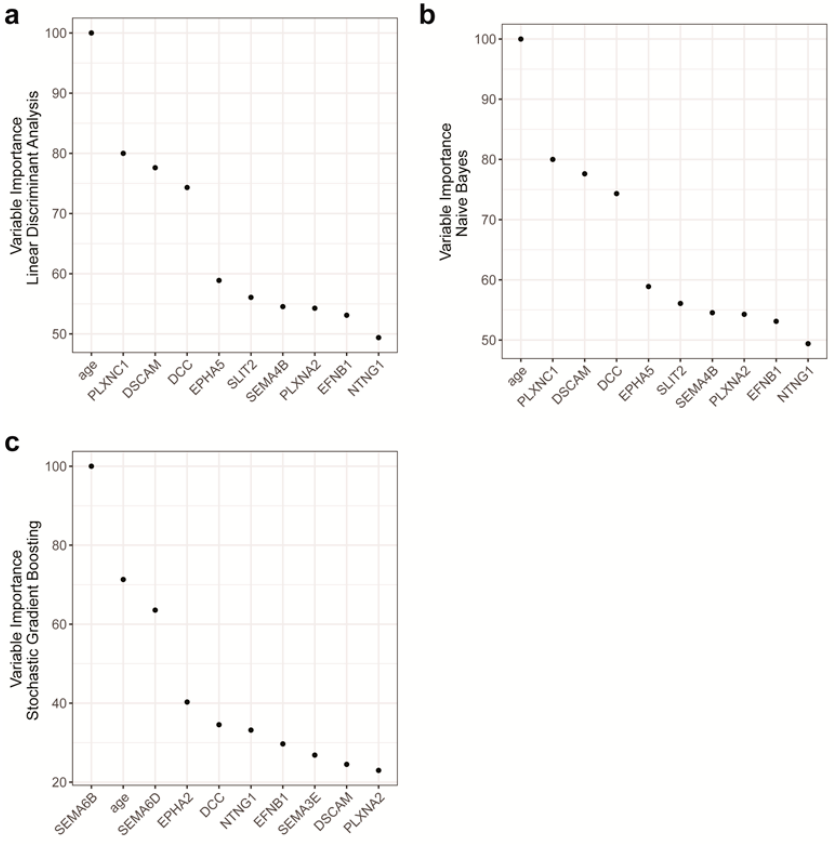
Figure 7. Variable importance of the models. ( a – c ) Variable importance measured in the linear discriminant analysis ( a ), Naïve Bayesian model ( b ) and stochastic gradient boost model ( c ). The importance of the most important feature was scaled to 100.